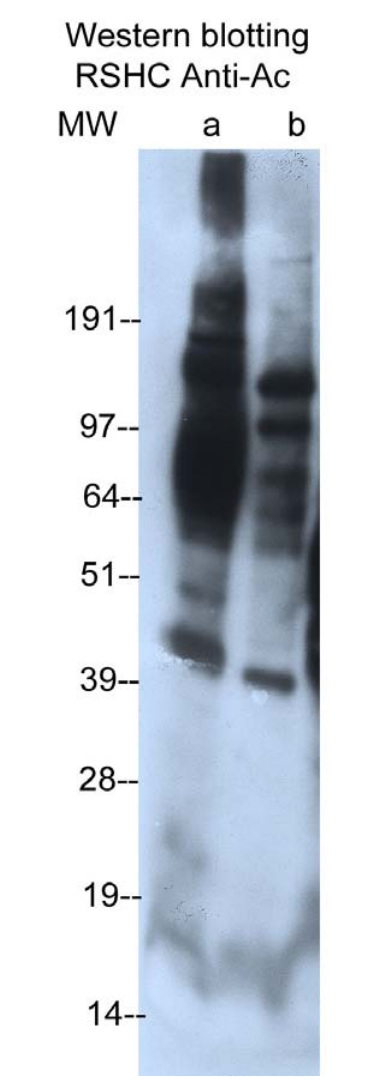
Figure 1. The venoms from L. quinquestriatus ( A ) and A. crassicauda ( B ) were separated and transferred to membranes. Bands are detected using the RSHC anti- Ac (1:4,000). Molecular weight (MW): SeeBlue® Plus2 (Invitrogen Corporation,